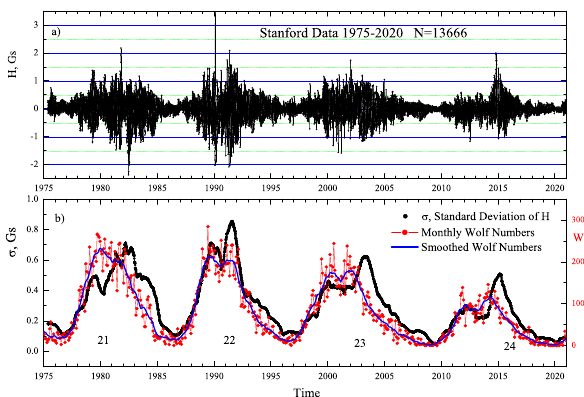
Figure 1. a) Original data of WSO from 1975 to 2020. b) Standard deviation σ of WSO data (black, left scale); Wolf numbers averaged over the month (red dots) and their smoothed curve (blue line)— right scale.